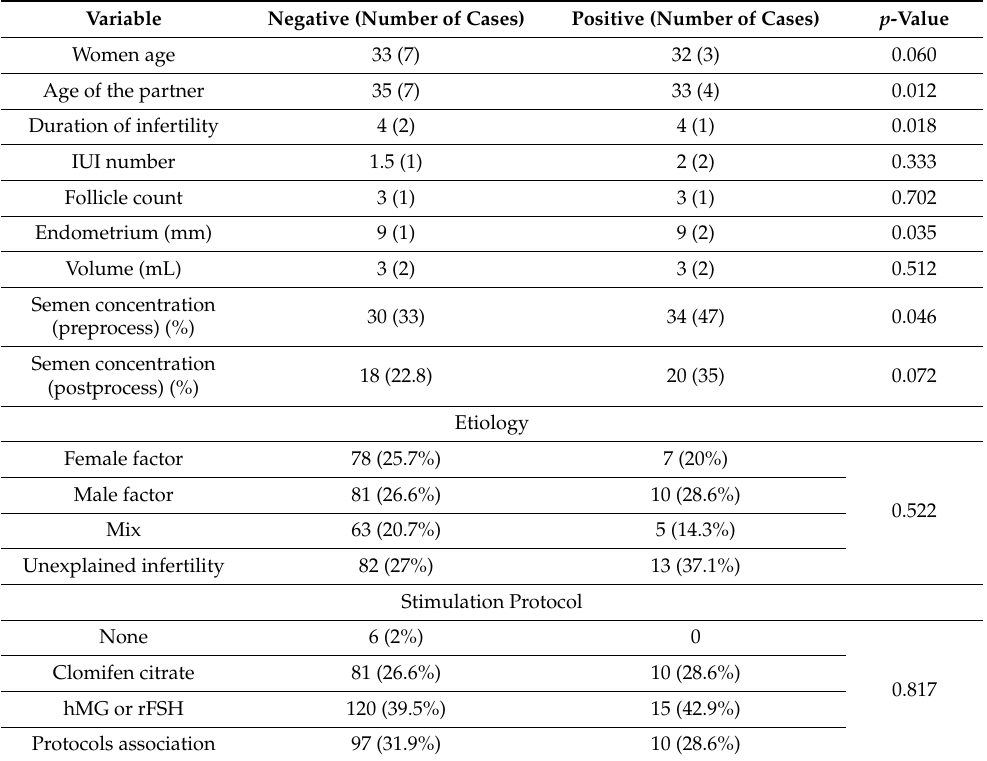
Table 1. Variables associated with intrauterine insemination